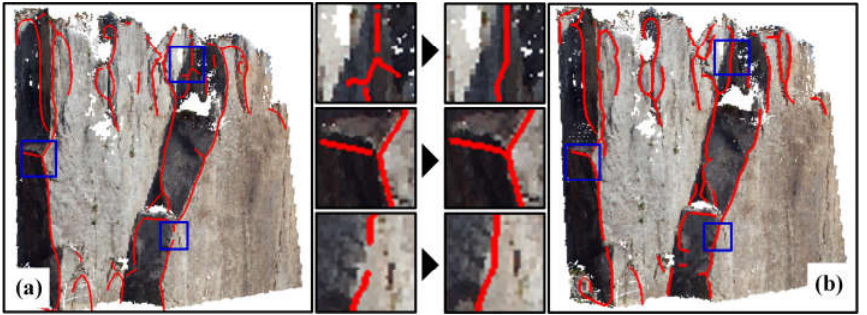
Figure 14. Comparison with existing methods. ( a ) A traditional region-growing connection algorithm; ( b ) the proposed algorithm.